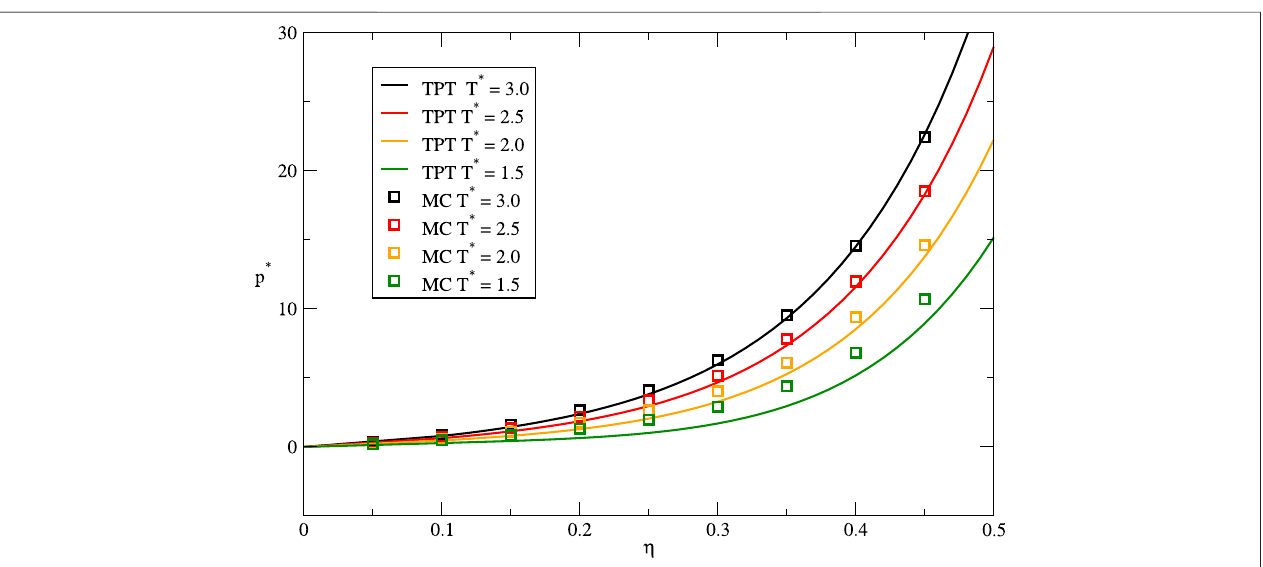
FIGURE3| Variousisothermsoftheparabolic-well fl uidfor λ (cid:2) 1 . 75.ThelabelTPTindicatesthattheresultshavebeenobtainedusingthermodynamicperturbation theory while the label MC refers to Monte Carlo simulation